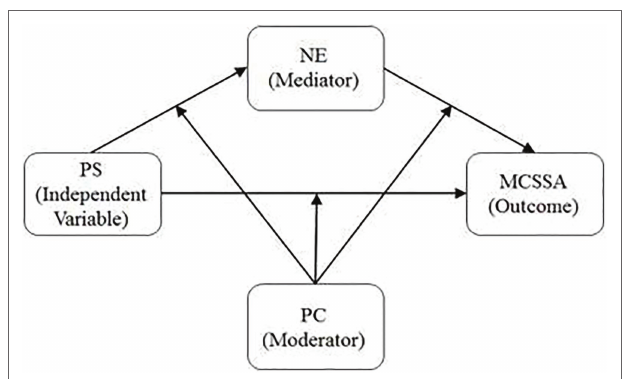
FIGURE 1 | The proposed moderated mediation model. PS, perceived stress; NE, negative emotion; PC, psychological capital; MCSSA, medical college student smartphone